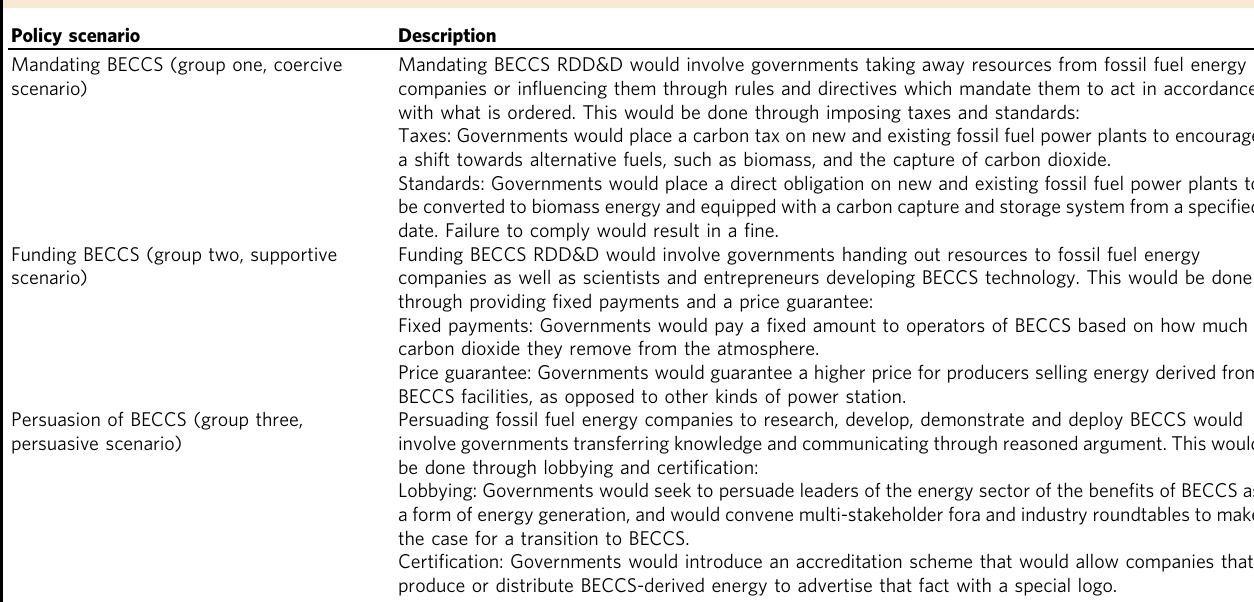
Technical aspect Information provided Carbon removal potential